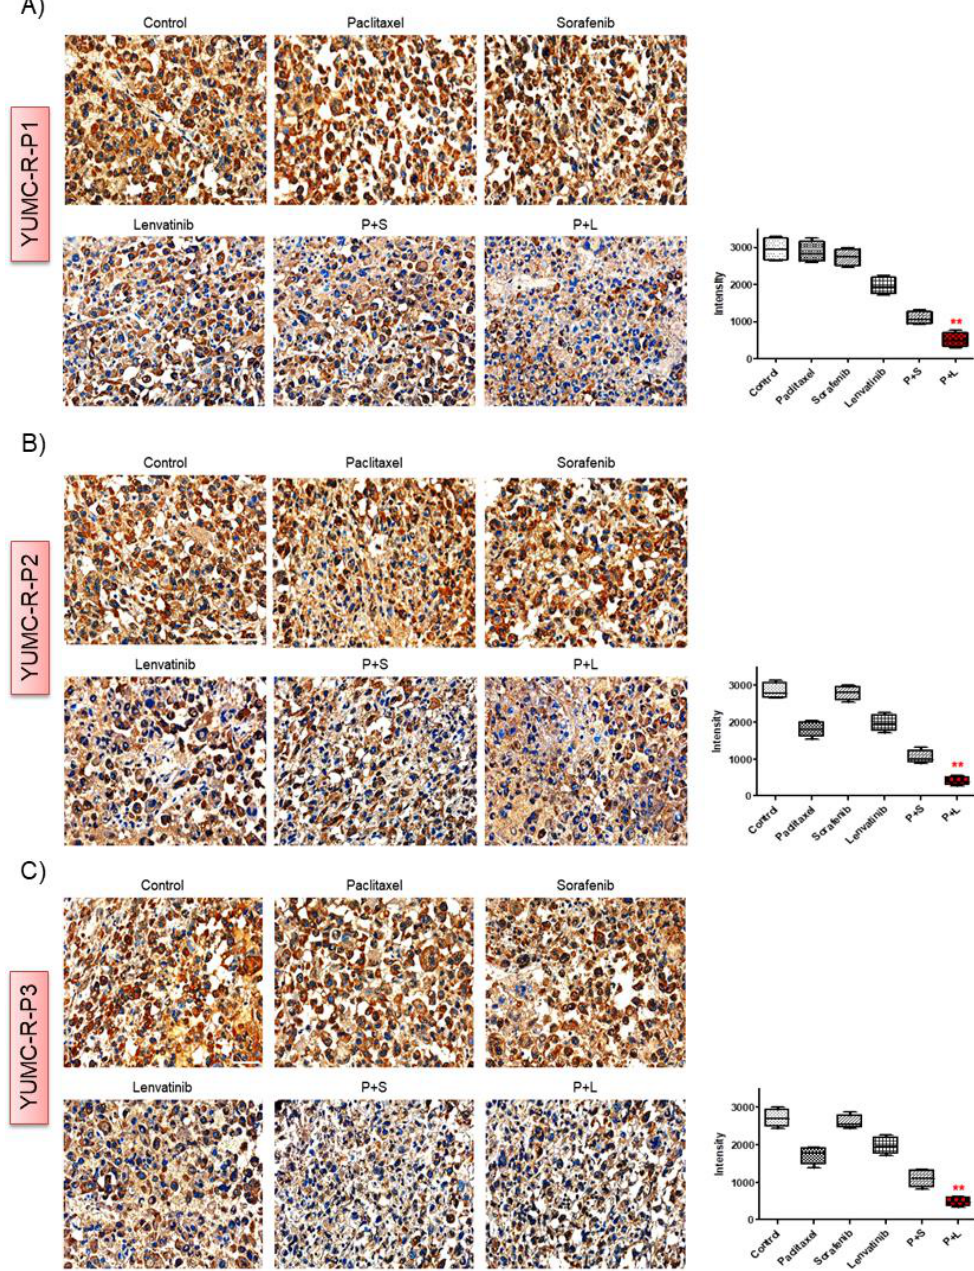
Figure 6. Immunohistochemical analysis of Bcl-2 proteins in tumor tissues following the indicated treatments. ( A ), YUMC-R-P1, ( B ), YUMC-R-P2, and ( C ), YUMC-R-P3 cells examined at 400 × magnification; scale bar: 80 μm. Each assay was performed in triplicate, and the representative images are presented. ** p < 0.01 versus control. MetaMorph 4.6 image analysis software was used to quantify the immunostained target proteins.